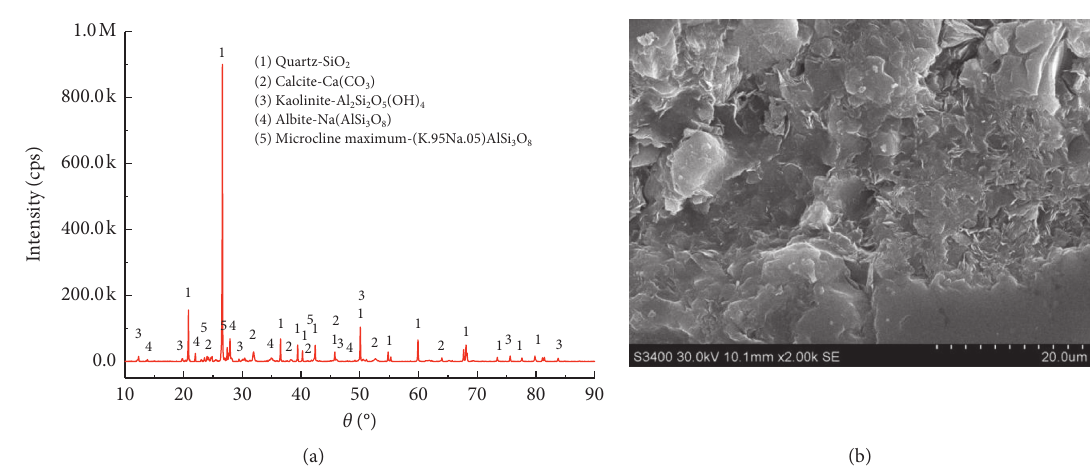
Figure 2: XRD spectrum and SEM observation of argillaceous sandstone sample (20 ° C). (a) XRD results. (b) SEM results.